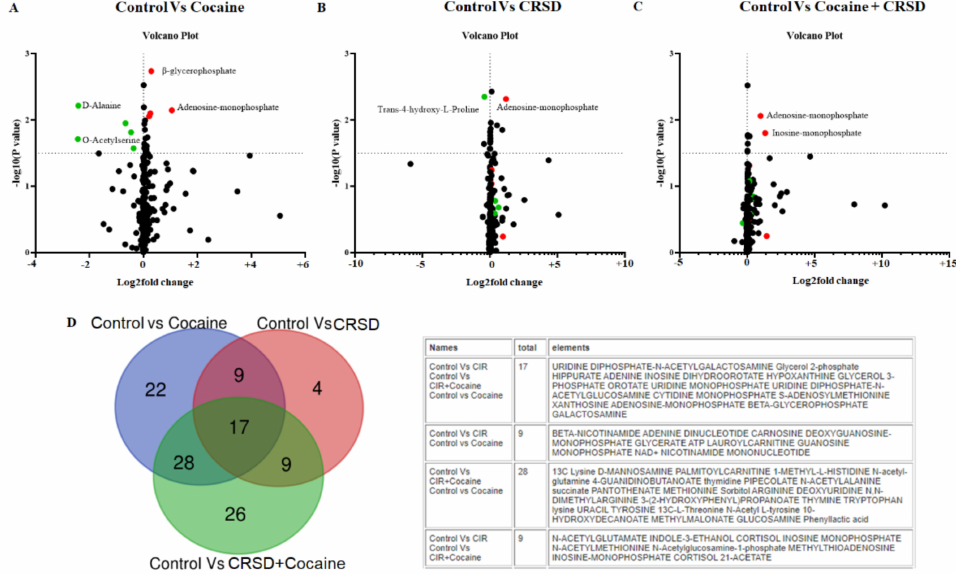
Figure 3. Summary of metabolite changes in the mouse plasma samples of the circadian disruption (CRSD), cocaine, CRSD, and control groups. ( A ) Volcano plot presenting the differential expression of metabolites in the cocaine group compared to the control. The X-axis corresponds to fold changes (FCs) of − 2 (downregulation) and +2 (upregulation). The Y-axis represents the − log10( p value). The red and green points on the plot represent the significantly differentially expressed (DE) metabolites. ( B ) Volcano plot presenting the differential expression of metabolites in the CRSD group compared to the control. The X-axis corresponds to FCs of − 2 (downregulation) and +2 (upregulation). The Y-axis represents the − log10( p value). The red and green points in the plot represent the signifi- cantly DE metabolites. ( C ) Volcano plot presenting the differential expression of metabolites in the cocaine + CRSD group compared to the control. The X-axis corresponds to FCs of − 2 (downregu- lation) and +2 (upregulation). The Y-axis represents the − log10( p value). The red and green points in the plot represent the significantly DE metabolites. ( D ) Venn diagram showing the 17 common identified metabolites among the control vs. cocaine, control vs. CRSD and control vs. cocaine + CRSD